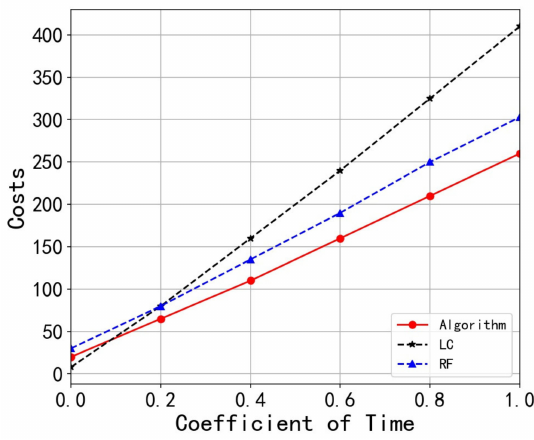
Figure 8. Simulation results with diverse λ